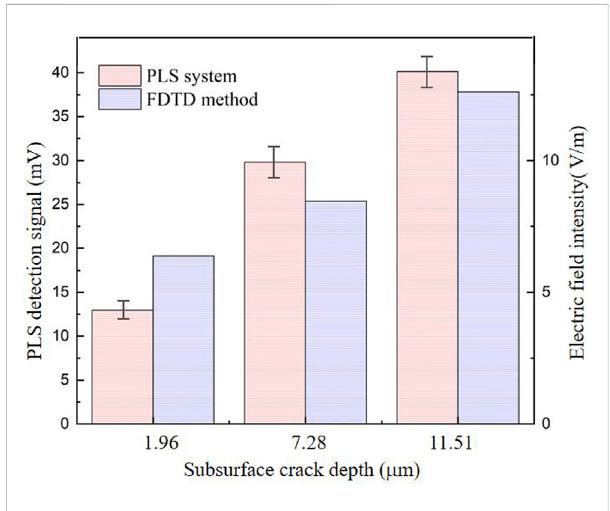
FIGURE 6 Comparison of detection signals and electric fi eld intensity